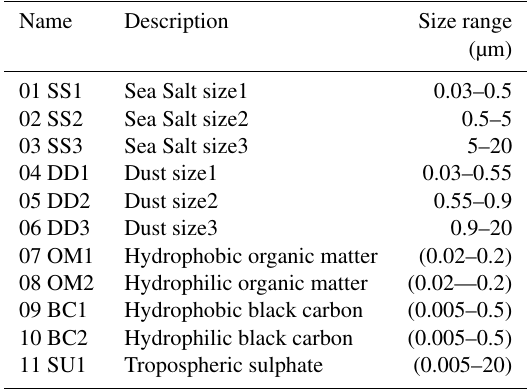
Table 2. CAMS aerosol